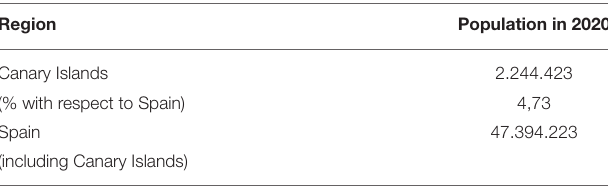
TABLE 1 | Population in the Canary Islands and Spain. Source: Instituto Nacional de Estadística (INE).